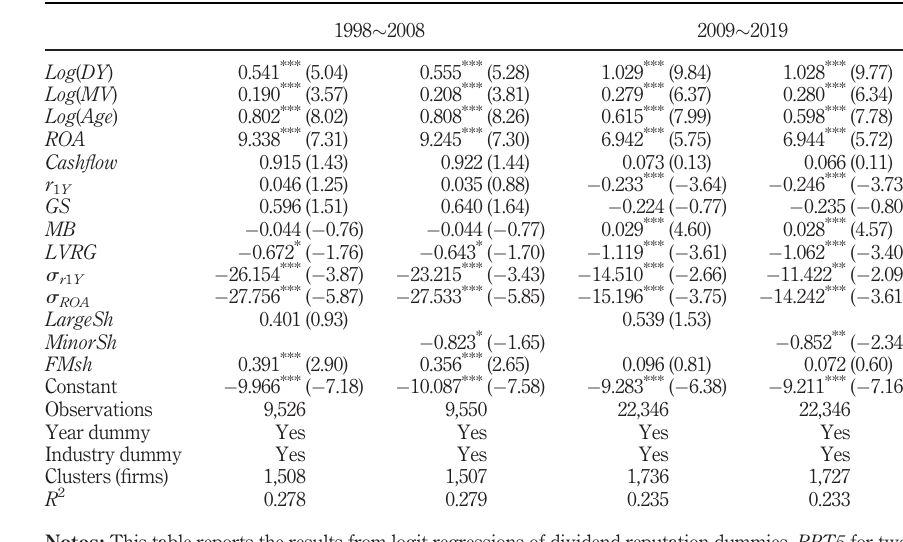
Table 6. Determinants